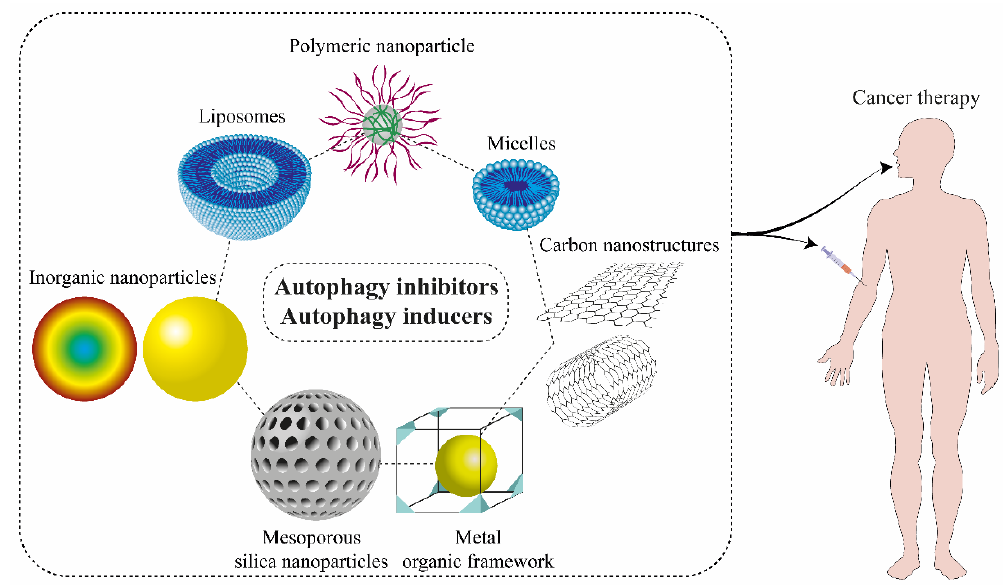
Figure 3. Various nanocarriers for delivery of autophagy modulators.